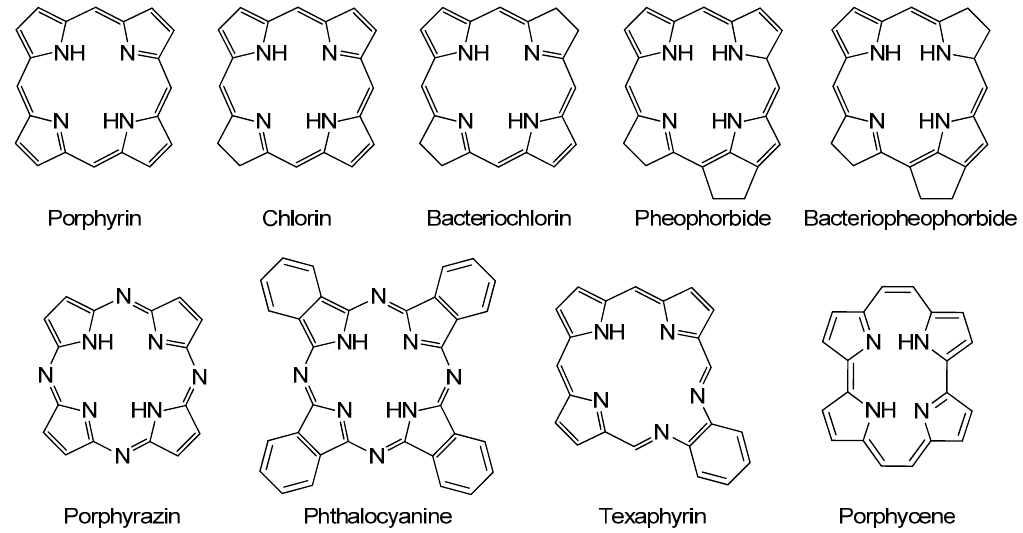
Figure 2. Examples of molecular skeletons of porphyrinoid-based PSs.